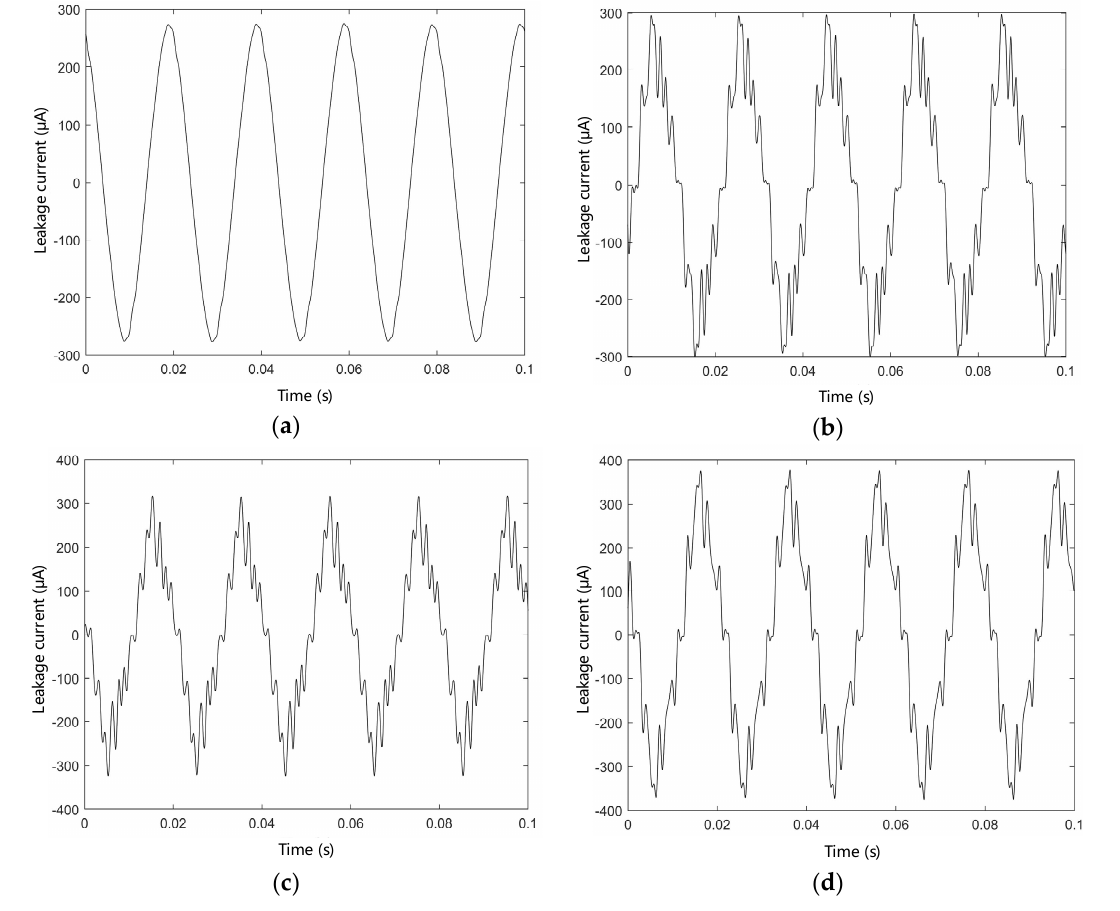
Figure 5. The leakage current test results of cable samples. ( a ) Unaged; ( b ) aging for 12 days; ( c ) aging for 24 days; ( d ) aging for 48 days.